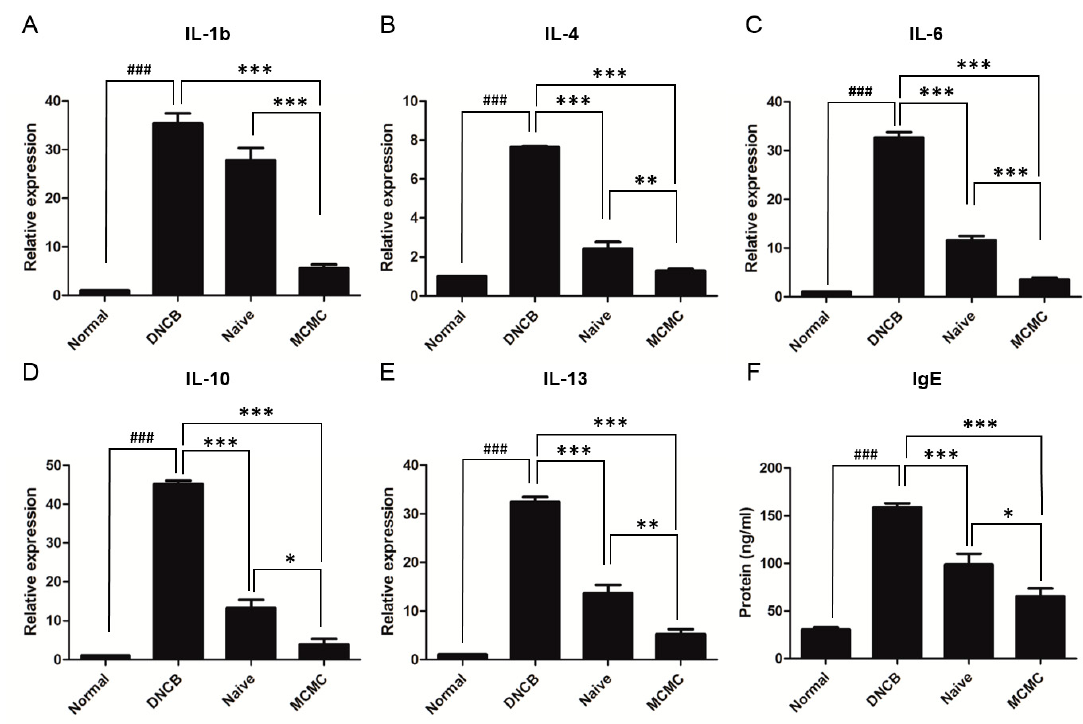
Figure 4. MCMC inhibits cytokine expression. Effects of MCMC on cytokine expression. ( A – E ) Effects of MCMC on the mRNA expression levels of inflammatory cytokines in DNCB-induced AD-like skin lesions. The DNCB group’s dorsal skin tissues of mice were cut on day 21 and the rest of the groups were cut on day 31. The relative mRNA expression levels of IL-1b, IL-4, IL-6, IL-10, and IL-13 were analyzed using quantitative PCR. ( F ) The blood samples by cardiac puncture were collected at day 21 (DNCB group), 31 (the rest of the groups). Total levels of serum IgE were measured by ELISA. Data are shown as mean ± SEM in qPCR data and as mean ± SD in ELISA data (* p < 0.05; ** p < 0.01; *** p < 0.001; ### p < 0.001).